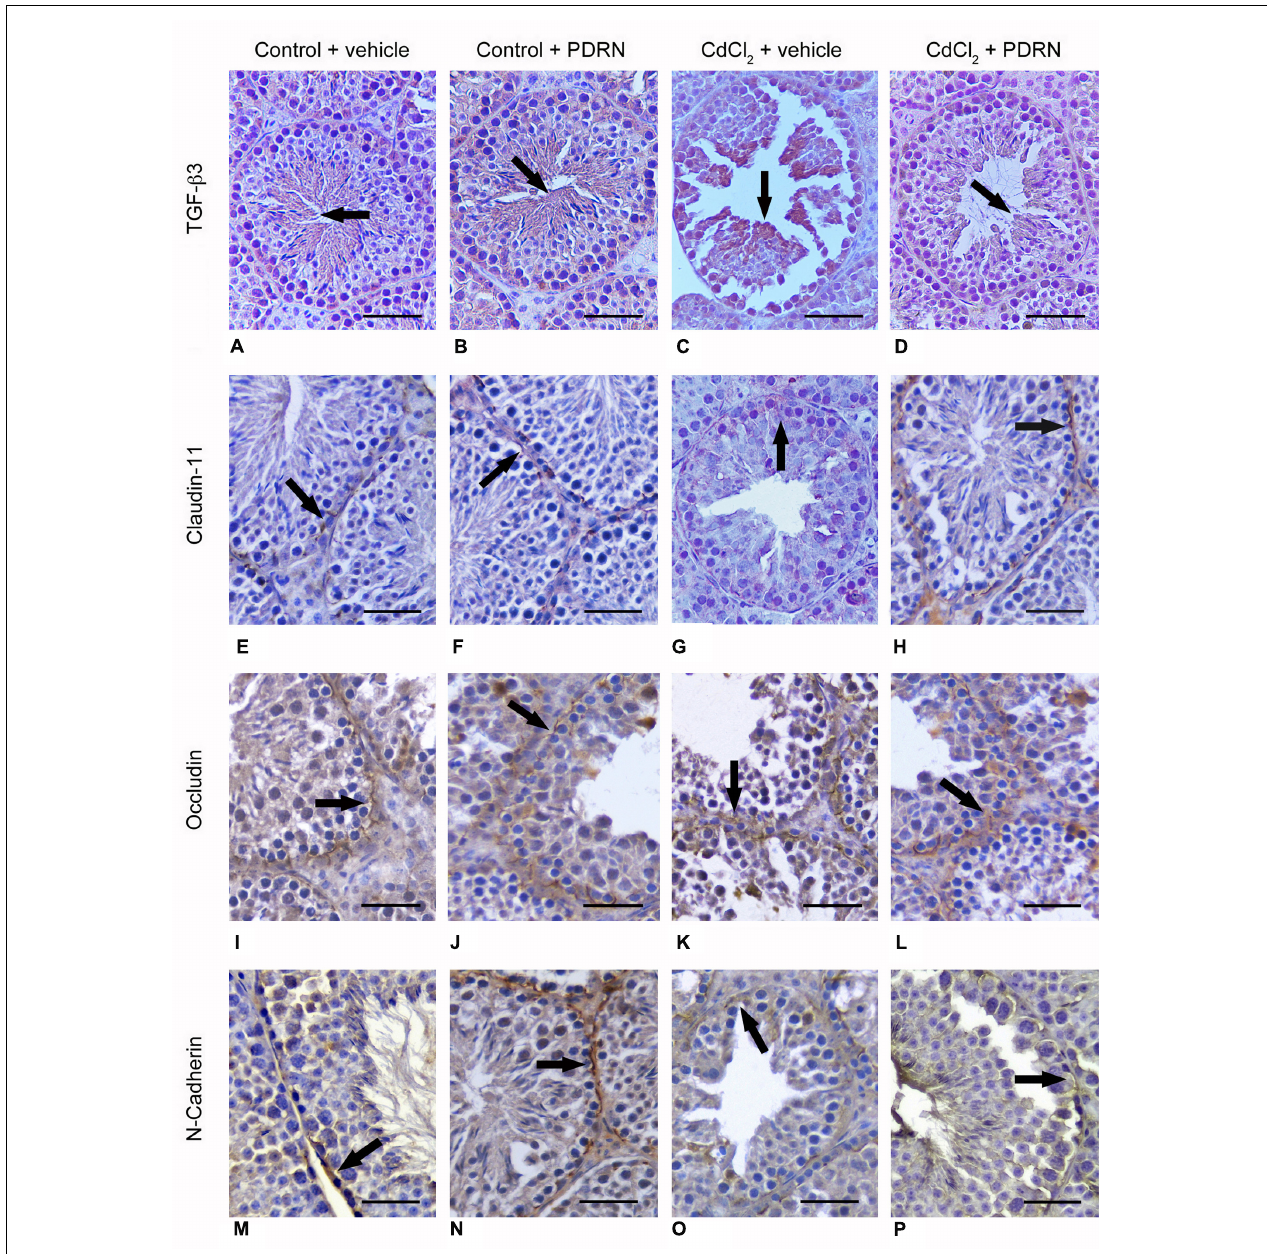
FIGURE 6 | Immunohistochemical localization of TGF- β 3 (A–D) , claudin-11 (E–H) , occludin (I–L) , and N -cadherin (M–P) in the testes from control plus vehicle animals (A,E,I,M) , control plus PDRN (8 mg/kg i.p.) animals (B,F,J,N) , CdCl2 (2 mg/kg i.p.) plus vehicle animals (C,G,K,O) , and CdCl2 (2 mg/kg i.p.) plus PDRN (8 mg/kg i.p.) animals (D,H,L,P) . (A,B) Arrow, TGF- β 3 adluminal immunoreactivity. (C) Arrow, increased TGF- β 3 reactivity of round spermatids. (D) Arrow, weak TGF- β 3 adluminal immunoreactivity. (E,F) Arrow, normal basal claudin-11 immunoreactivity. (G) Arrow, weak and irregular claudin-11 immunoreactivity. (H) Arrow, basal claudin-11 immunoreactivity. (I,J) Arrow, normal basal occludin immunoreactivity. (K) Arrow, diffuse, irregular occludin immunoreactivity. (L) Arrow, occludin immunoreactivity along the basal compartment. (M,N) Arrow, N -cadherin immunoreactivity in the basal part of seminiferous epithelium. (O) Arrow, irregular basal positivity for N -cadherin. (P) Arrow, basal immunoreactivity for N -cadherin. (Scale bar: 50 µ